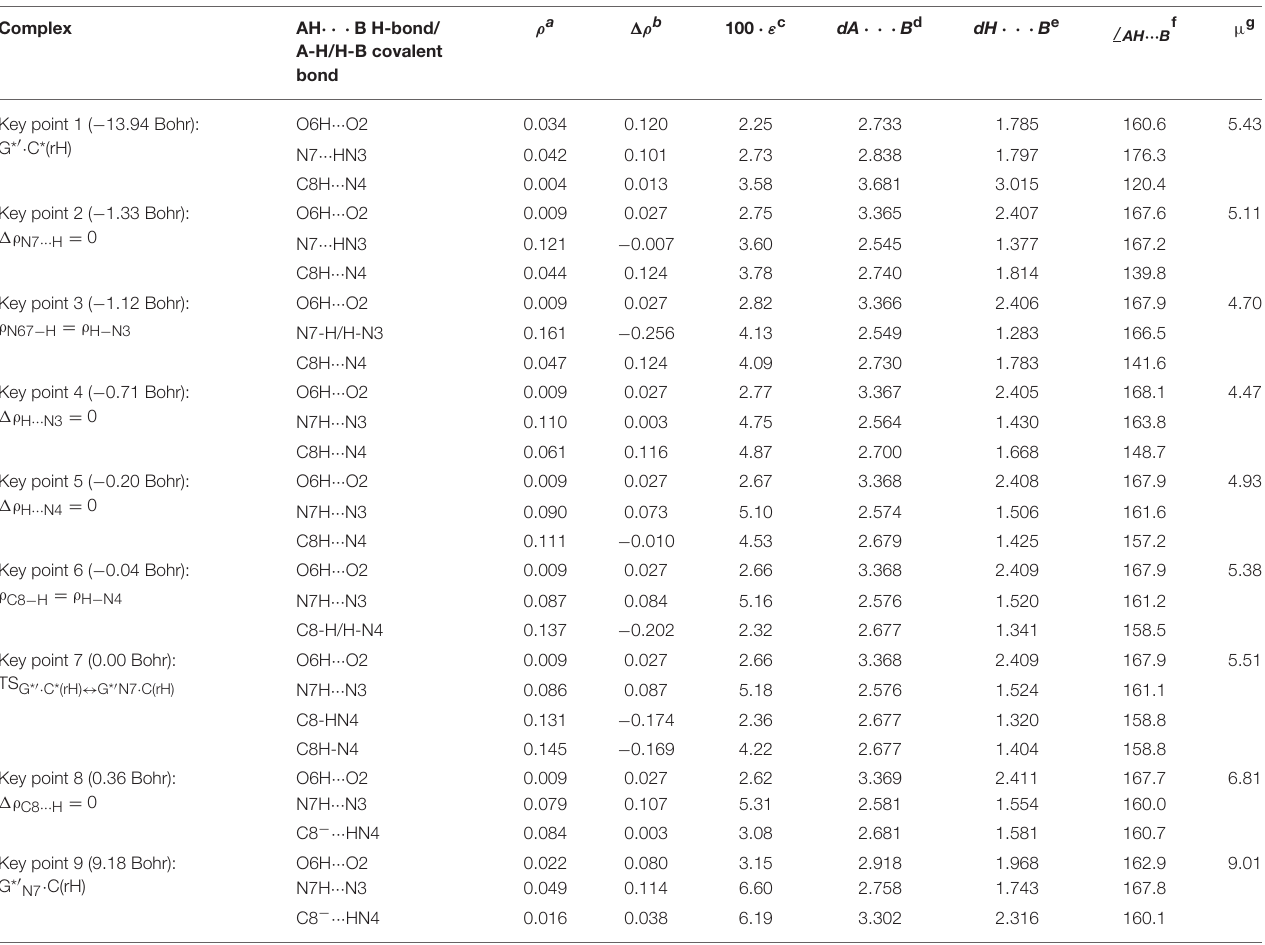
TABLE 7 | Electron-topological and structural characteristics of the specific intermolecular bonds revealed in the 9 key points and the polarity of the latters along the IRC of the V.